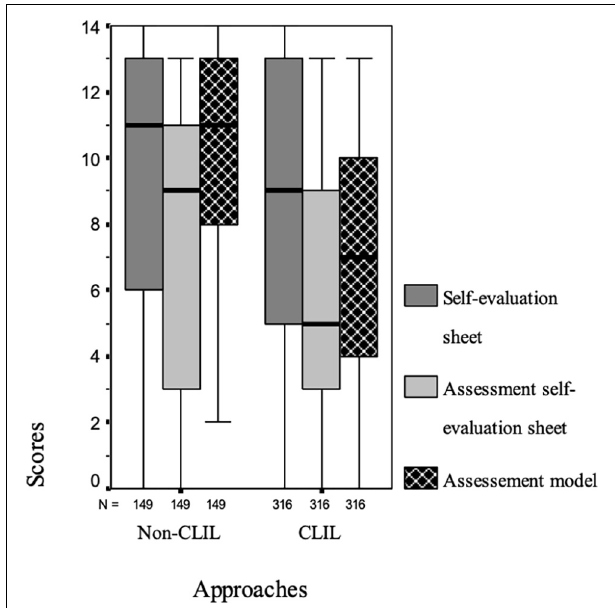
FIGURE 7 | Differences between non-CLIL and CLIL learners in scores for self-evaluation sheets, subsequent model assessment and reassessment of the students’ self-evaluation